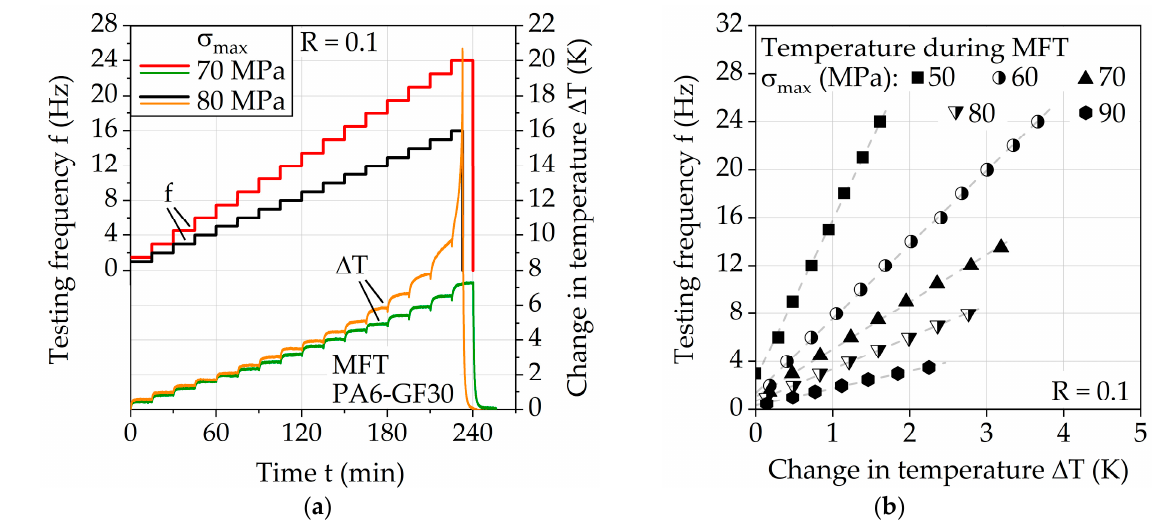
Figure 6. ( a ) Results of multiple frequency test at σ max = 70 and 80 MPa; ( b ) linear temperature–testing frequency relationship visualized for σ max = 50, 60, 70, 80 and 90 MPa.